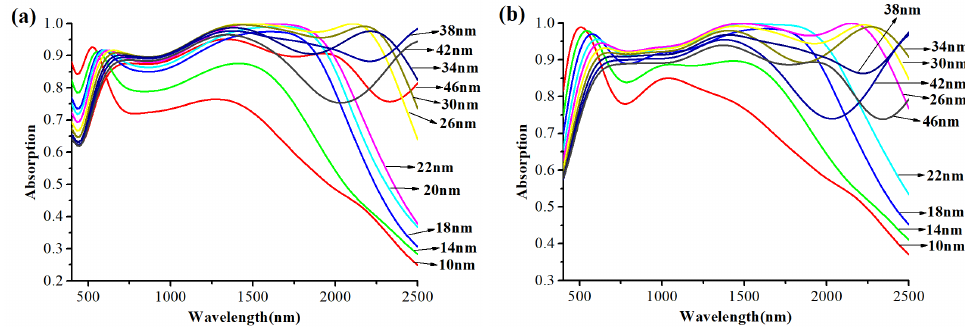
Figure 7. The absorption curves of the absorber with the diameter of the tungsten nanosphere increasing from 10 to 46 nm: ( a ) the thickness of the MXene layer is 30 nm; ( b ) the thickness of the MXene layer is 400 nm.